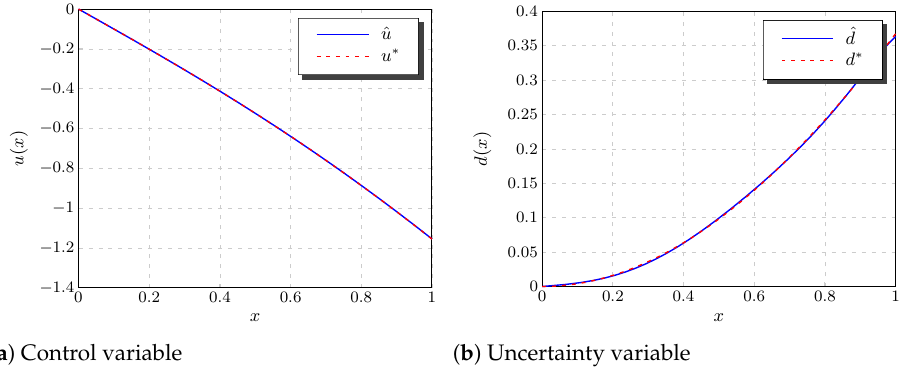
Figure 2. Control and uncertainty variables in dependence on the state variable (Example 4.1).